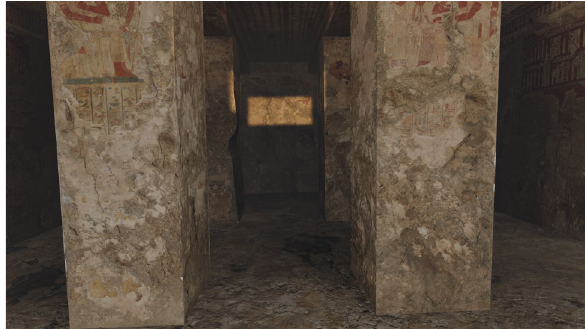
Figure 16 . step 3, view from the pillars’ hall with doors A, B & C open.